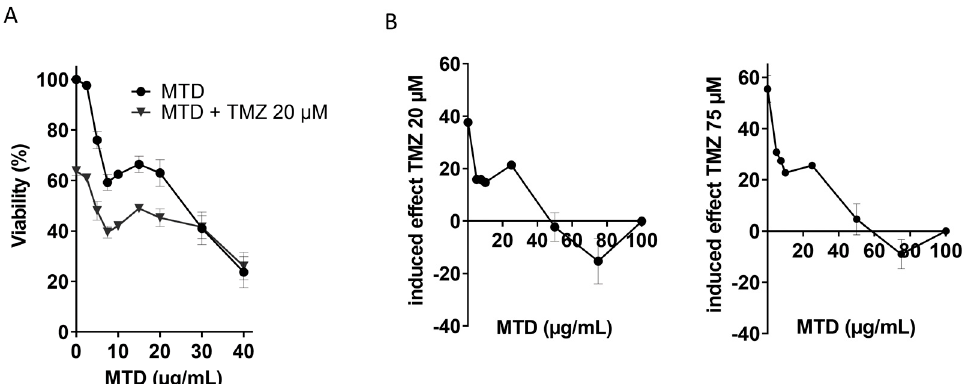
Figure 2. Cytotoxicity of TMZ measured in the MTT assay in the absence and presence of MTD. ( A ) Exponentially growing cells were treated with TMZ and increasing concentrations of MTD. Data are the mean of three separate experiments. ( B ) Induced effect of TMZ (20 and 75 µM, left and right panel, respectively) on the viability of LN229 cells co-treated with MTD. The toxic effect induced by MTD was subtracted from the effect obtained after combined treatment, shown in panel A for 20 µM TMZ. Viability was measured 120 h after addition of the drugs to the medium.